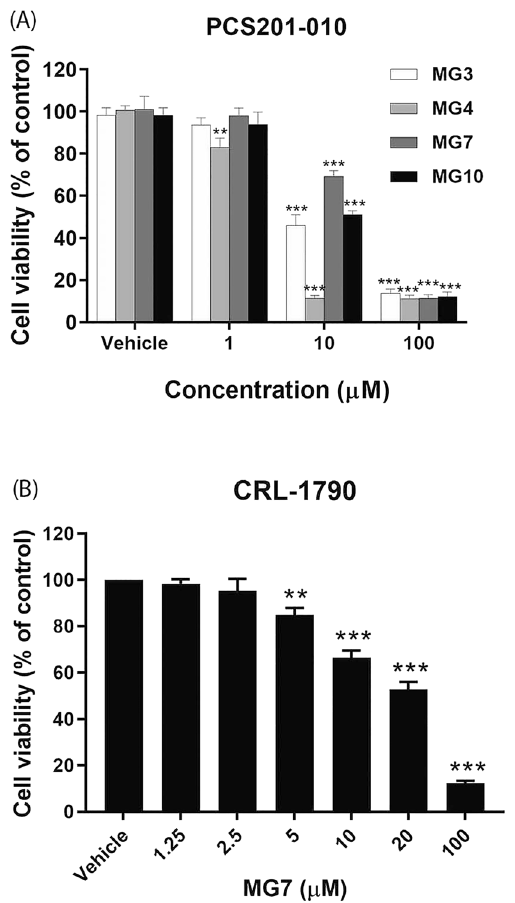
Figure 3. Effects of semi-synthetic derivatives of MGs on viability of ( A ) PCS201-010 and ( B ) CRL-1790 cells. The cells were treated with MG3, MG4, MG7 or MG10 at indicated concentrations for 48 h. Cell viability was evaluated using MTT assay. Data are presented as mean ± S.E.M of three independent experiments. ** P < 0.01 and *** P < 0.001 compared to vehicle control (0.2%